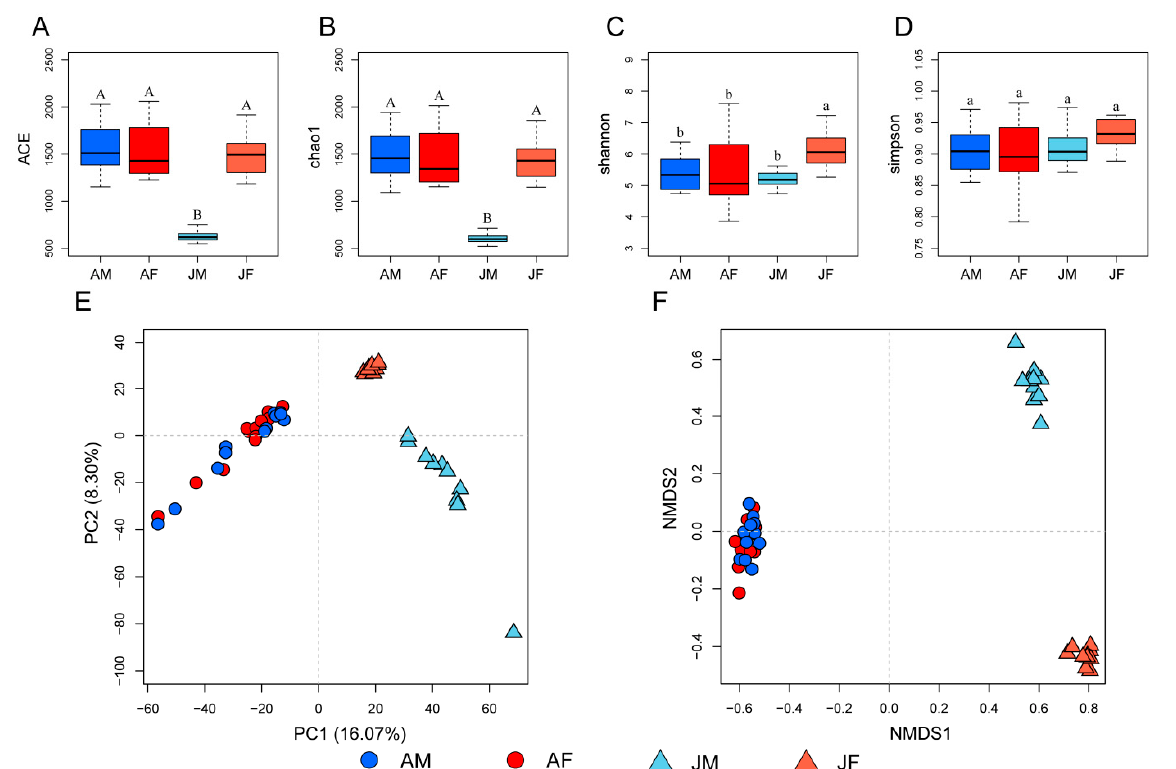
Figure 2. Community diversity of gut microbiota in Chinese alligators. Alpha diversity of gut microbial communities in each group illustrated using ACE ( A ), chao1 ( B ), Shannon ( C ), and Simpson ( D ) indices. Comparing beta diversity using principal component analysis (PCA) ( E ) and non-metric multi-dimensional scaling (NMDS) ( F ). 0.01 < p < 0.05 are marked with lowercase letters and p < 0.001 are marked with uppercase letters. AM: adult male; AF: adult female; JM: juvenile male; JF: juvenile female.